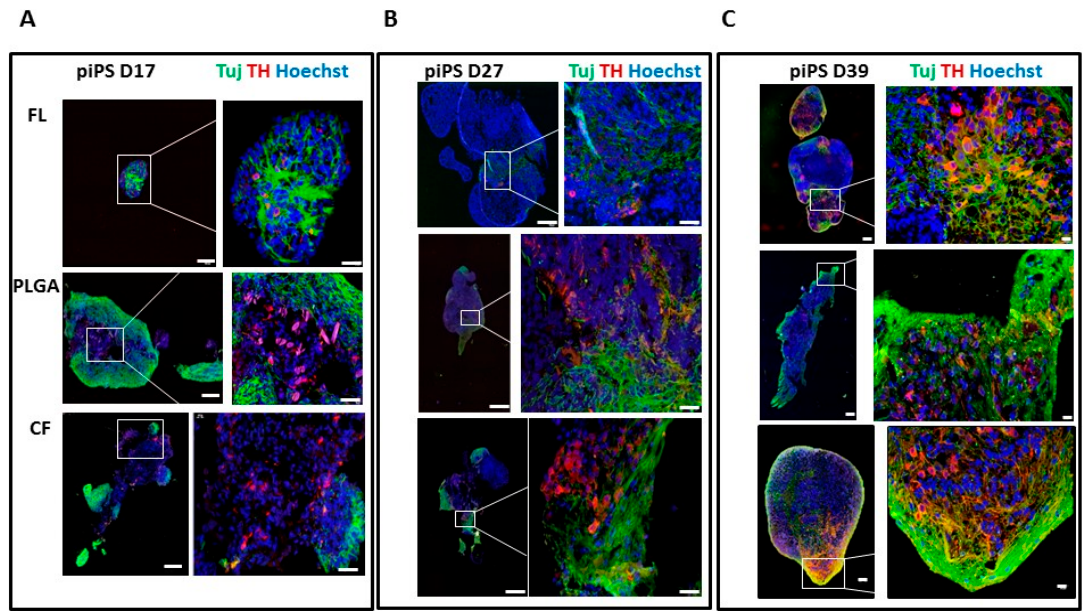
Figure 5. Immunofluorescent characteristics of the organoids. piPSC FL, piPSC PLGA, and piPSC CF were collected at time points corresponding to the crucial moments in the development of the brain—day 17 (D17) ( A ), day 27 (D27) ( B ), and day 39 (D39) ( C )—fixed in 4% paraformaldehyde (PFA) then embedded in para ffi n blocks and stained with neuron-specific class III β -tubulin (TUJ1), tyrosine hydroxylase (TH), the characteristic marker of mDA neurons, and nuclear marker Hoechst 33342. White scale bar 100 µ m (whole organoid, left side of each panel) or 20 µ m (fragment of organoid, right side of each panel).